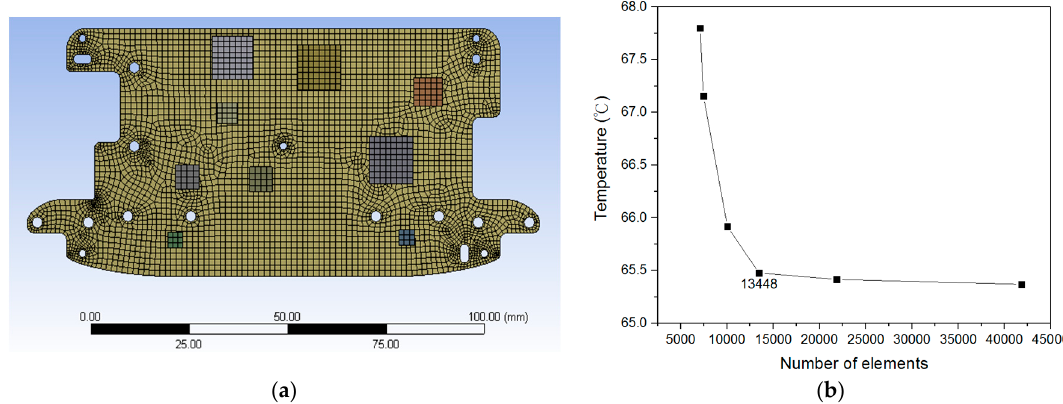
Figure 7. Mesh of single chip model. ( a ) Mesh. ( b ) Mesh convergence analysis. Appl. Sci. 2020 , 10 , 197